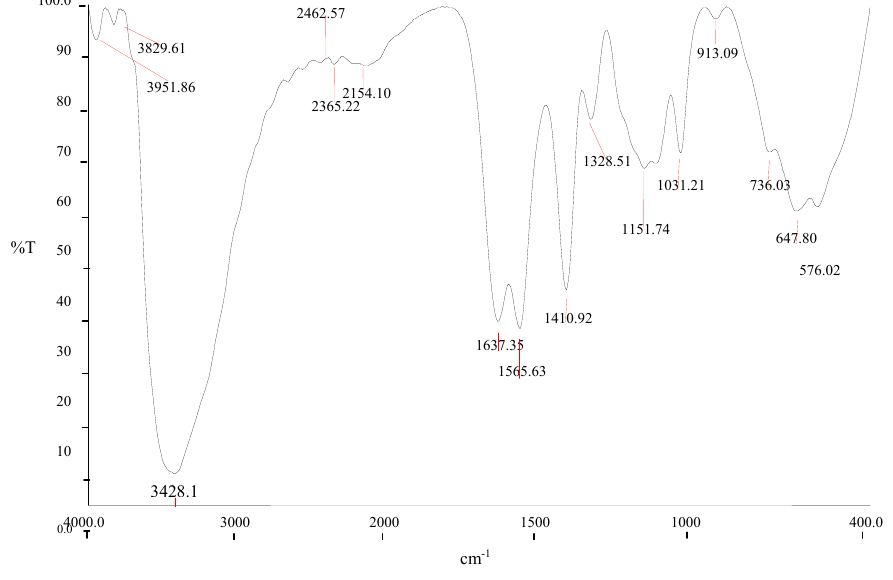
Figure 2. The IR spectrum of raw